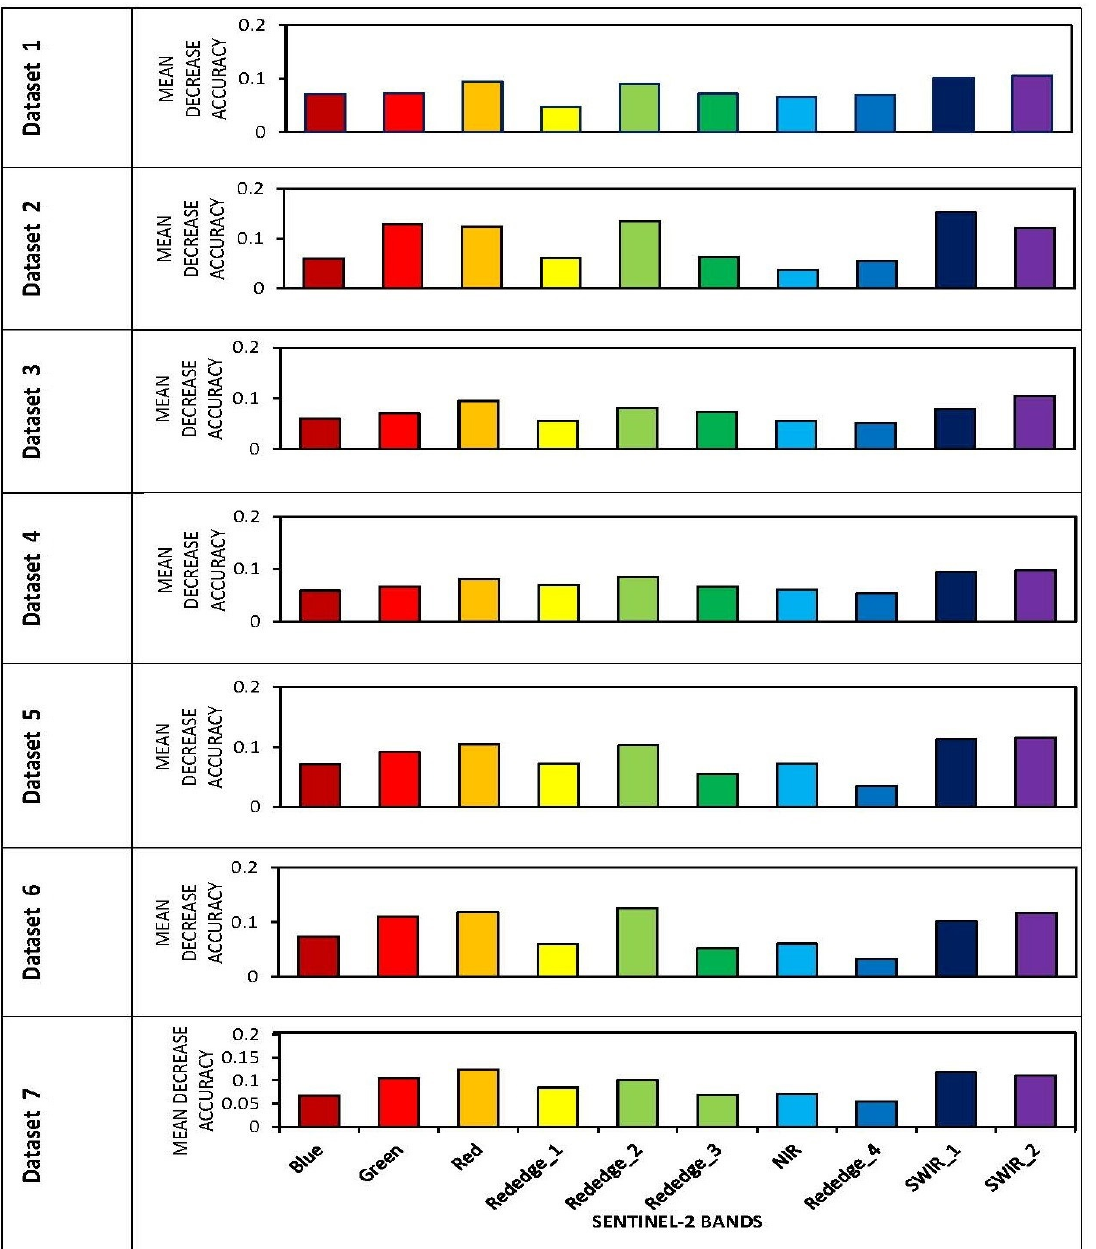
Figure 6. A comparative importance of explanatory variables used in permutation feature selection on seven datasets based on S2 spectral bands for Dataset 1 (balanced undersampled at 100 points), Dataset 2 (balanced undersampled at 150 points), Dataset 3 (undersampled randomly at 40%), Da ‐ taset 4 (undersampled randomly at 50%), Dataset 5 (undersampled randomly at 60%), Dataset 6 (undersampled randomly at 70%), and Dataset 7 (imbalanced dataset). The most influential bands are depicted by spikes indicating the highest feature importance scores. The color maroon, red, or ‐ ange, yellow, lime green, green, light blue, blue, dark blue and purple represent Sentinel ‐ 2 bands, namely: Band 2 (Blue), Band 3 (Green), Band 4 (Red), Band 5 (Rededge_1), Band 6 (Rededge_2), Band 7 (Rededge_3), Band 8 (NIR), Band 8a (Rededge_4), Band 11 (SWIR_1) and Band 12 (SWIR_2).